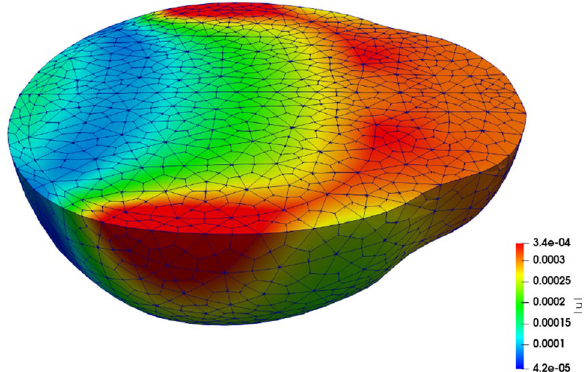
Fig. 11 Displacement magnitude after 0.1 s